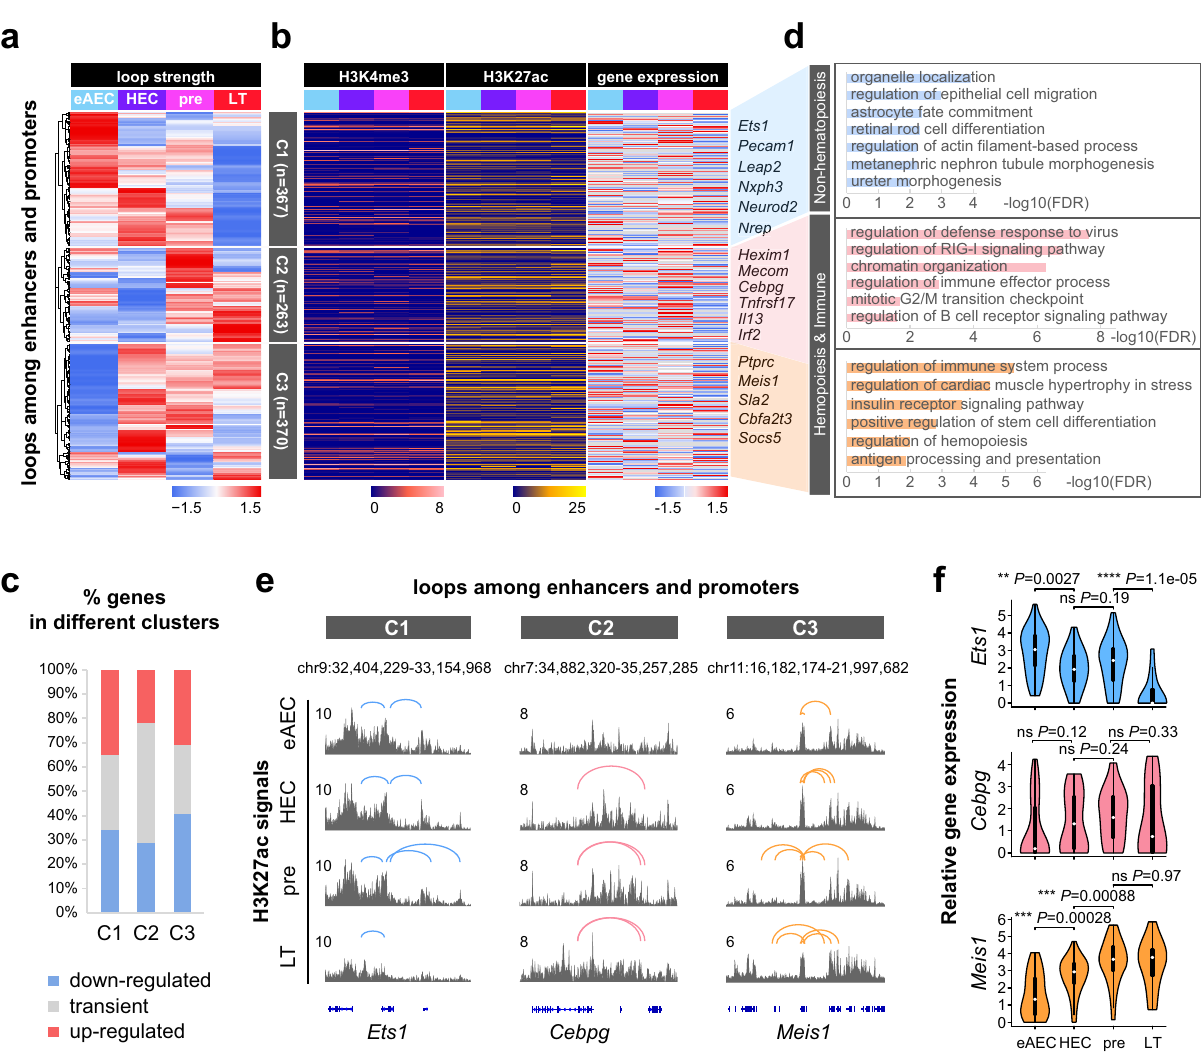
Fig. 3 Pre-con fi guration with feature histone modi fi cations precedes chromatin loop dynamics. a Heatmap showing clusters of top 1000 variable loops among enhancers and promoters by loop strengths (normalized CPM). Loops contained E – E, E – P, or P – P loops. b Heatmaps showing cognate H3K4me3, H3K27ac, and gene expression on anchors of each loop. Only reads on ChIP-seq peaks were used to calculate normalized signals of H3K4me3 and H3K27ac. The eAEC and HEC scRNA-seq data were from GSE139389. Pre-HSC and LT-HSC scRNA-seq data were from GSE67120 and GSE66954. Gene expression values were calculated and normalized with log2(TPM/10 + 1). c Percentages of genes in three loop clusters with down-regulated, transient, and up-regulated expression from eAECs to LT-HSCs. Transient genes meant those whose expression was up-regulated in some cases and down-regulated in others. d Biological process analysis of looping regions in three clusters. The inputs were these looping anchor regions for GO term analysis with GREAT. The − log10(FDR) values were shown after BH correction. e Track views showing the loop change trend among enhancers and promoters at the Ets1, Cebpg, and Meis1 loci. f Violin plots showing expression of representative genes in three clusters with log2(TPM/10 + 1). The scRNA-seq data contain 42 eAECs, 33 HECs, 50 pre-HSCs and 16 LT-HSCs. Box-and-whiskers plots represented the maxima, 75th percentile, median, 25th percentile, and minima. Wilcoxon Rank Sum test (two-sided) was performed between two adjacent stages. * P -value< 0.05, ** P -value< 0.01, *** P -value< 0.001, **** P -value< 0.0001, “ ns